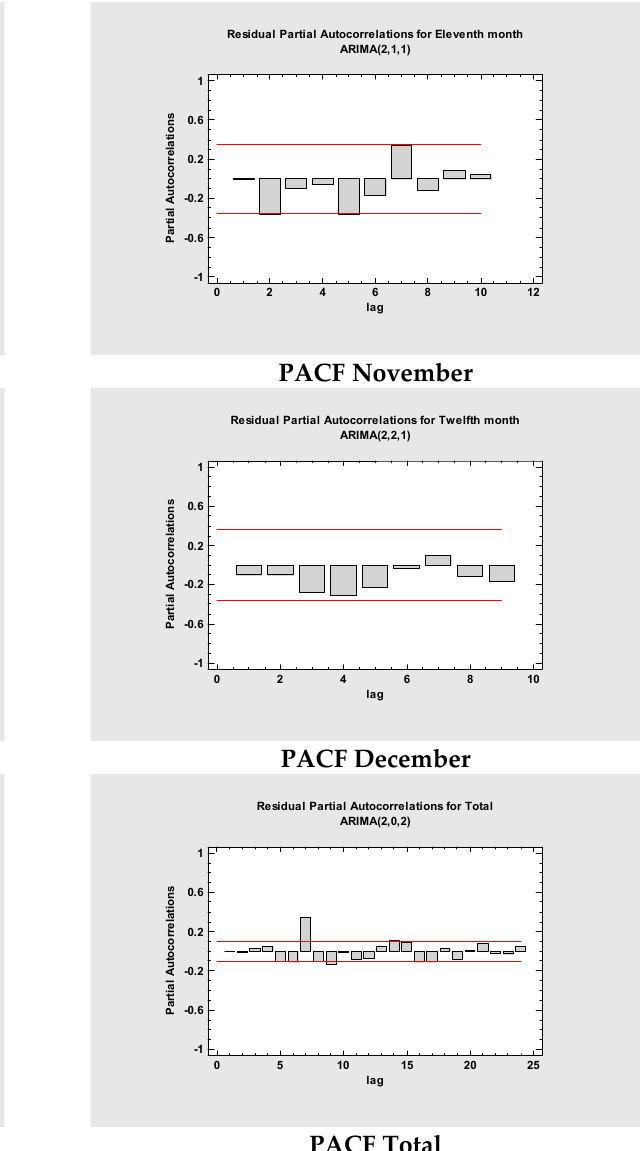
Figure 4. The estimated ACF and PACF graphs used to predict the vaccination trend against COVID-19 in Romania per each month and cumulative. In Figure 4 (left and right) are displayed the associated plots for the estimated partial and autocorrelations between residuals at distinct lags. Specifically, the lag x, partial and autocorrelation, coefficients evaluate the affinity between the residuals at a time t and time (x − t) (for autocorrelation)/(x + t) (partial autocorrelations) at 95.0% probability to be close to 0. Distinct from autocorrelation is the condition that t + x accounts for the correlations at all lower lags, observation used to appreciate the order of autoregressive model where needed to fit the data. Valid for both functions if the probability at a specific for au- tocorrelation/particular for partial autocorrelation lag do not contain the estimated coefficient, in- deed exists a statistically significant correlation at that lag at CI 95.0%.